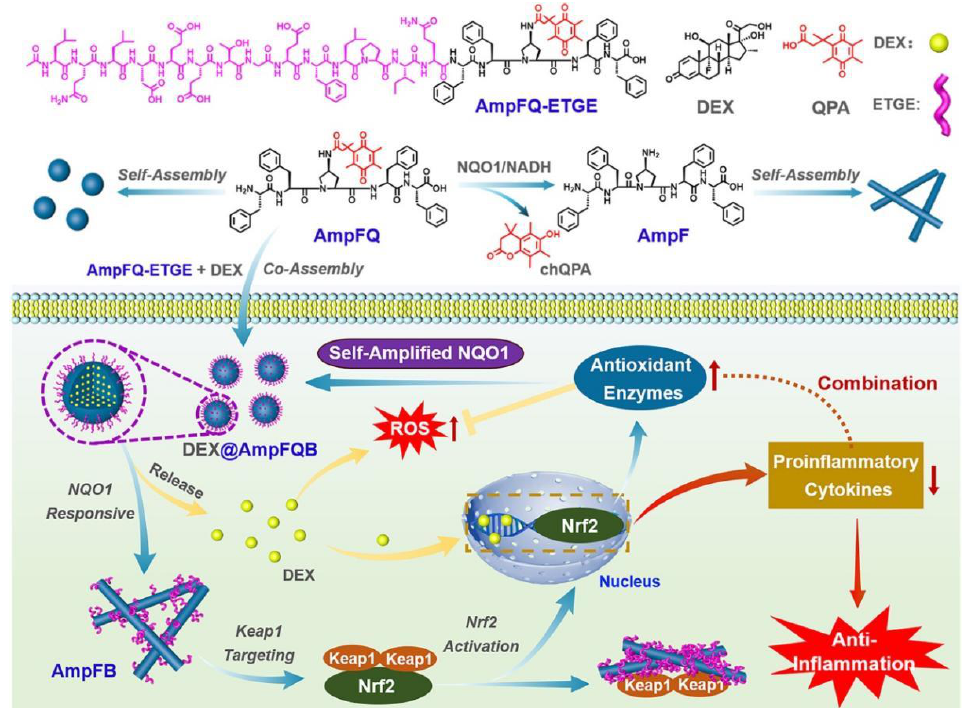
Figure 9. Schematic presentation showing the NQO1-responsive self-amplifying assembly of pep- tides in macrophages. Reprinted/adapted with permission from [121]. Copyright 2022, American Chemical Society.